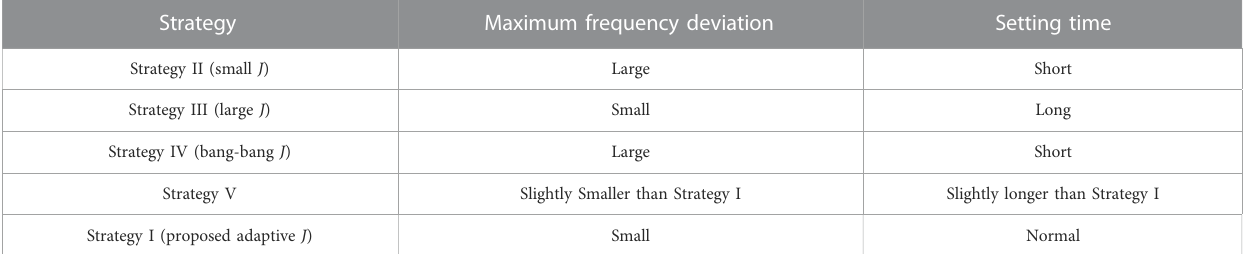
TABLE 2 Comparison of dynamic response under different